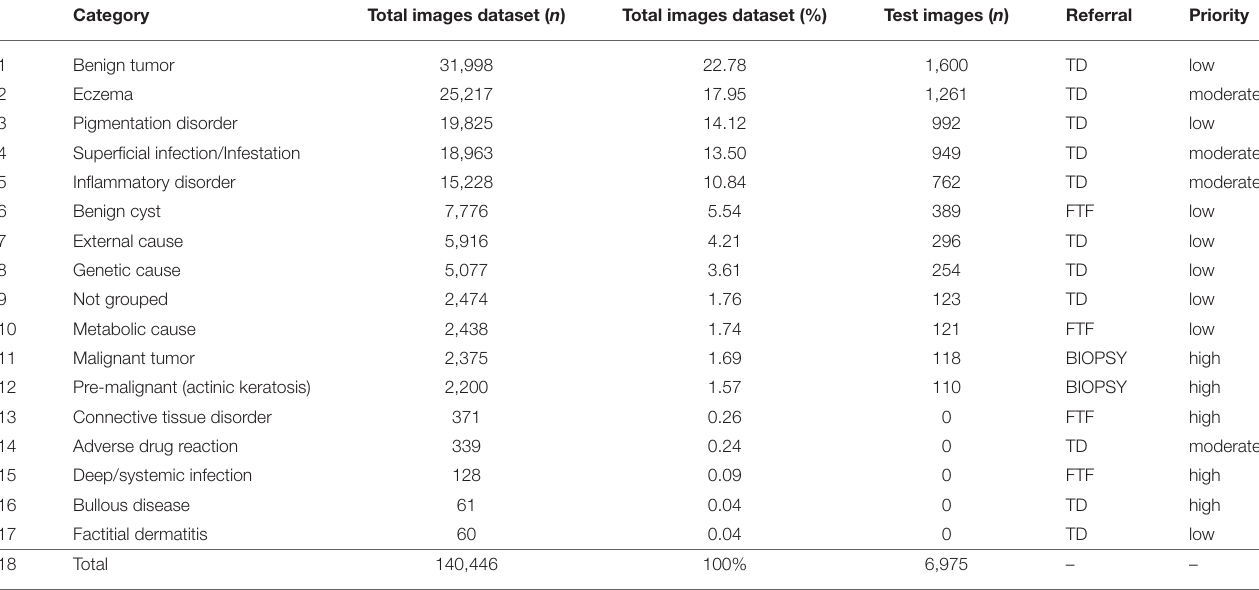
TABLE 1 | Categories of target classes dermatological diseases, their contribution in the dataset of images, referral and level of priority, according to our dermatologists’ standard of care.